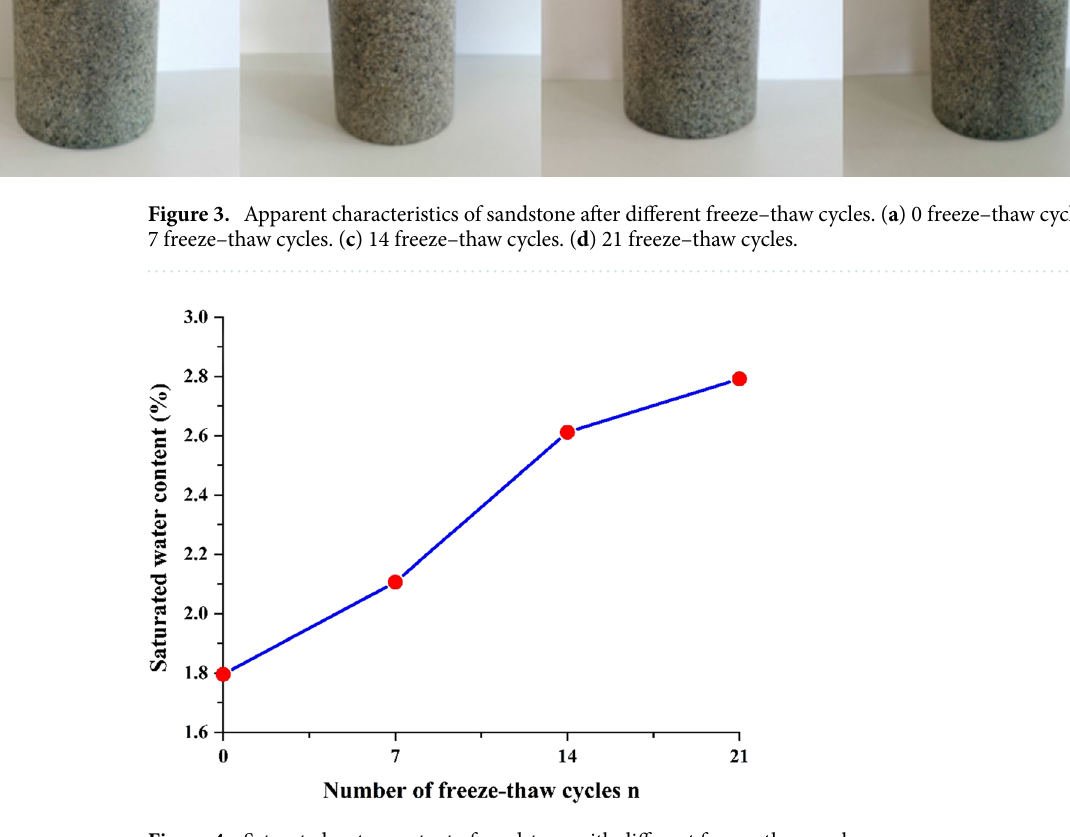
Figure 4. Saturated water content of sandstone with different freeze–thaw